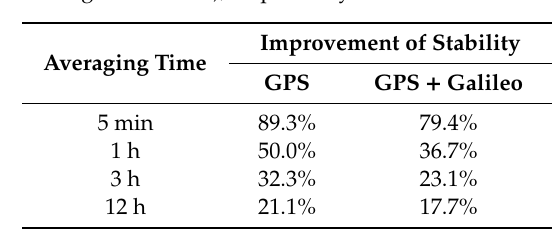
Figure 8. ADEVs of aligned CCD results in INRIM.